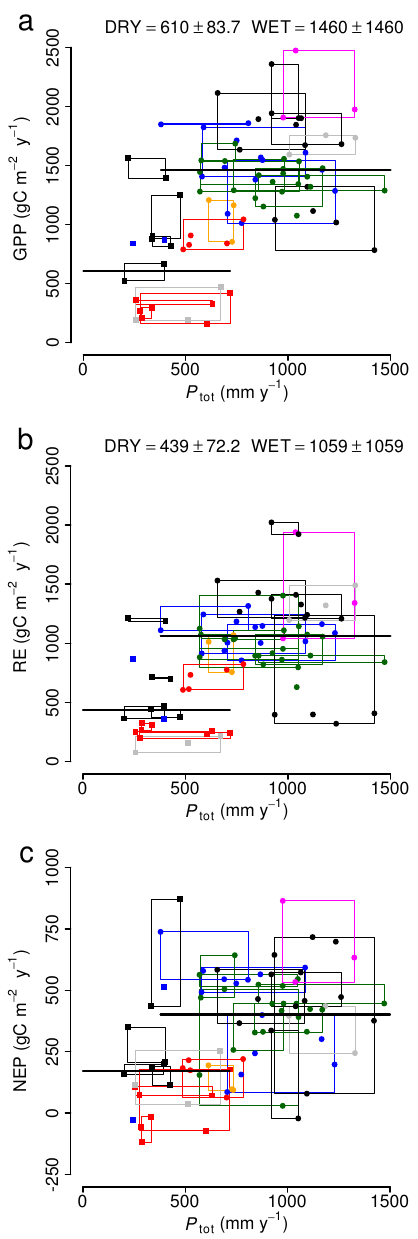
Fig. 2. Relationship between total annual rainfall and (a) GPP, (b) RE, and (c) NEP. Each point represents a single site-year (“dry” sites as squares, “wet” as circles, colour-coded by the IGBP ecosys- tem type: grey – CSH, green – DBF, blue – EBF, black – ENF, magenta – MF, orange – SAV, red – WSA). Horizontal lines show the piecewise-constant model values for fluxes of the “dry” (black) and “wet” (grey) groups of sites; for NEP, the lines show the dif- ferences between the GPP and RE models. Model parameters and standard errors for the site-year fits are shown at the top of the GPP and RE panels. Rectangles cover the range of interannual variability for each